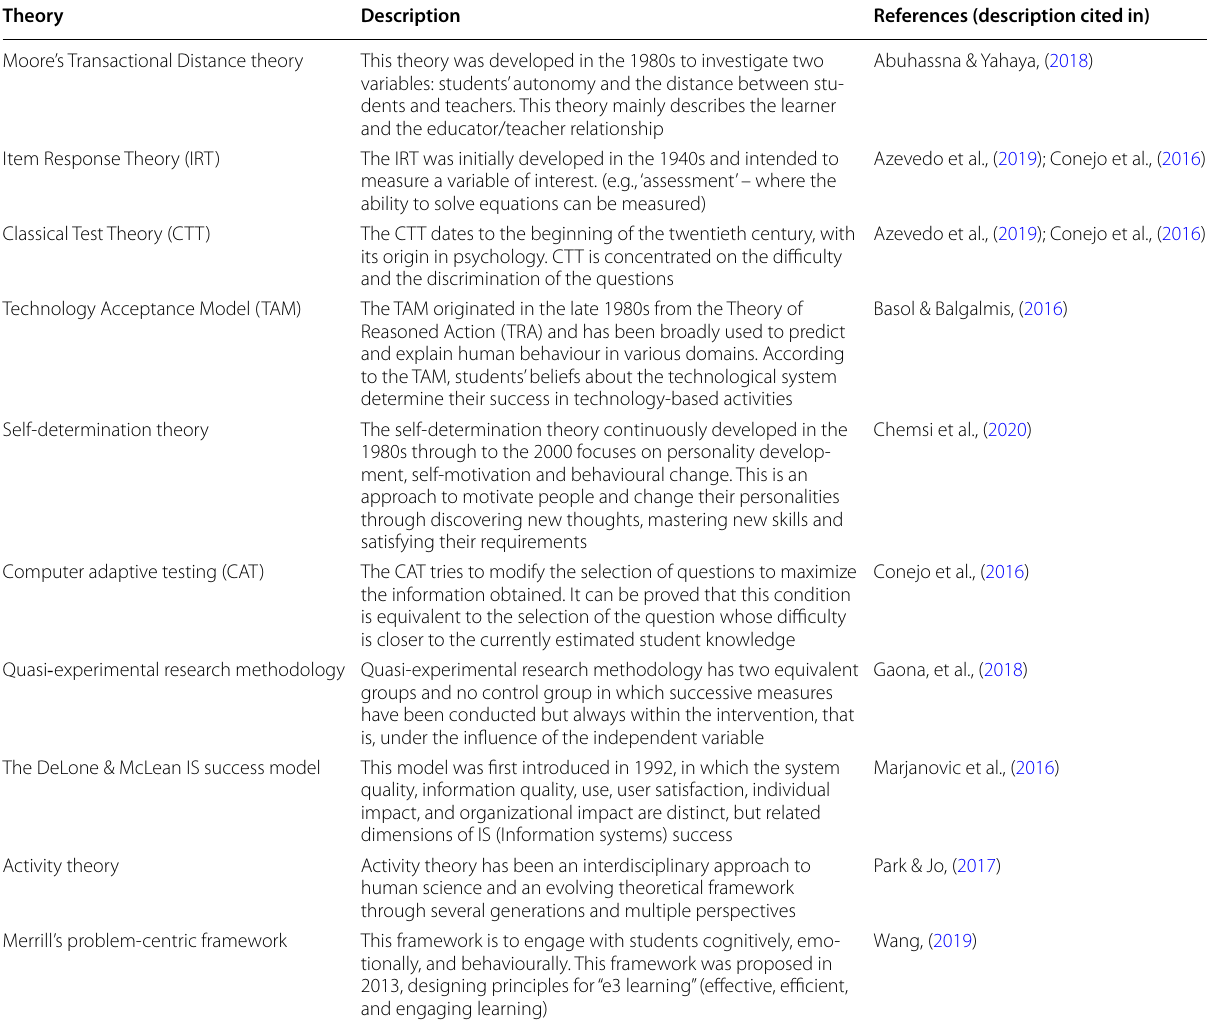
Table.6 Education theories used in research and